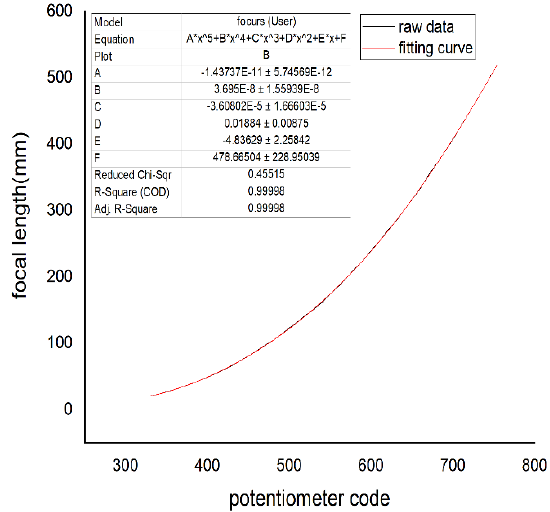
Figure 16. Quartic polynomial fitting.